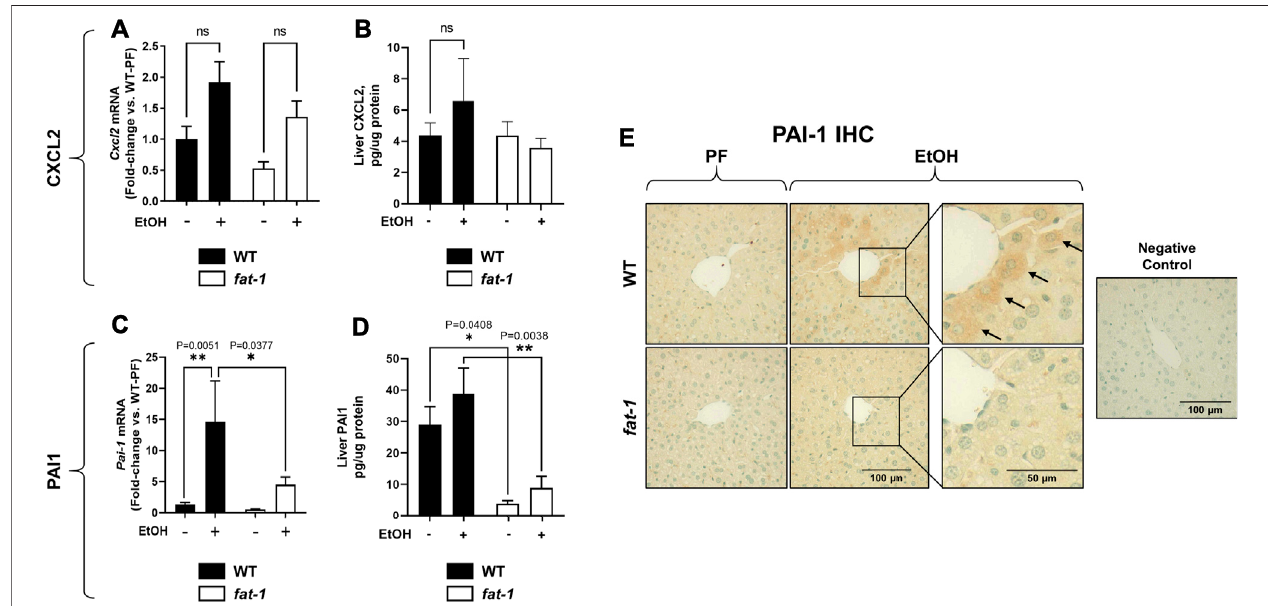
FIGURE 4 | Hepatic Expression of Cxcl2 and Pai-1. (A) Expression of Cxcl2 mRNA and (B) CXCL2 protein in liver. (C) Expression of Pai-1 mRNA and (D) PAI-1 protein in liver. (E) Liver immunohistochemistry for PAI-1 protein, 400X magni fi cation. Arrows indicate PAI-1+ hepatocytes. *, p < 0.05, ** p < 0.01, one-way ANOVA (comparisons not signi fi cant if unlabeled). WT PF ( n (cid:1) 14), fat-1 PF ( n (cid:1) 9), WT EtOH ( n (cid:1) 8), fat-1 EtOH ( n (cid:1) 10).